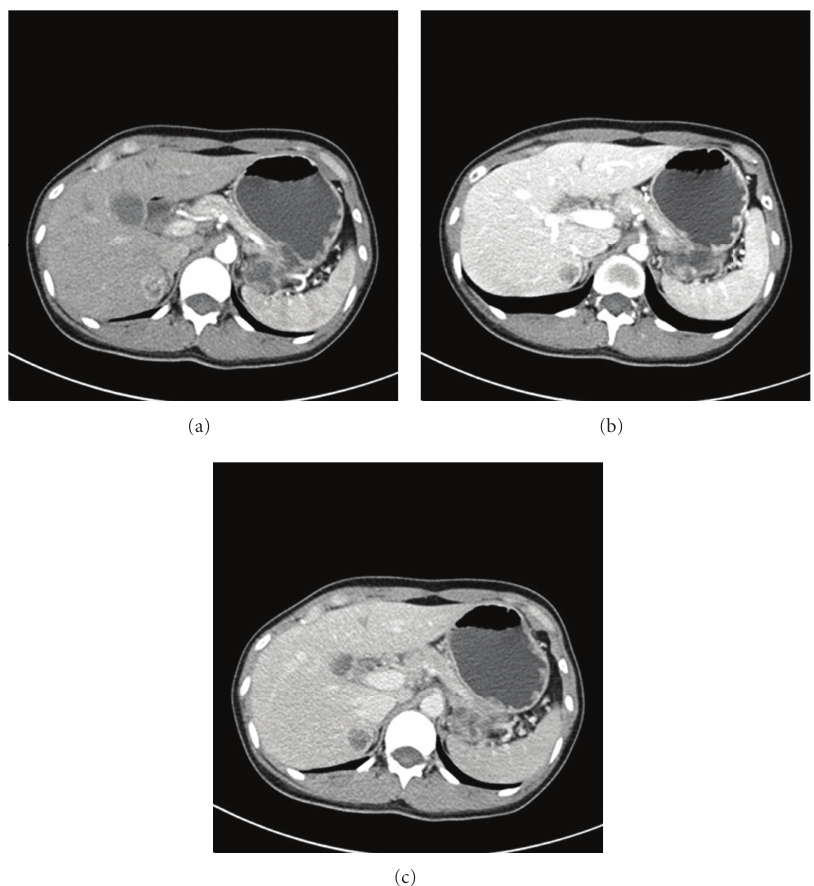
Figure 2: CT findings of the liver mass. Contrast-enhanced CT revealed a heterogeneous hypervascular mass in the arterial phase (a) and washing-out of the medium in the portal (b) and delayed phases